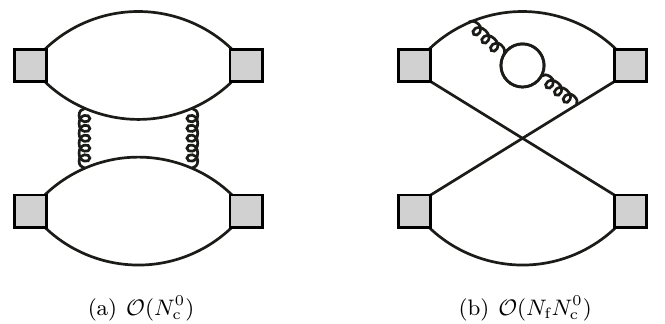
Figure 3 . Subleading diagrams in the large N c scaling of the Wick contractions D and C in figure 2. Grey squares represent a pion operator, solid lines represent quark lines, and wavy lines are gluons. The scaling of each diagram is given in their respective